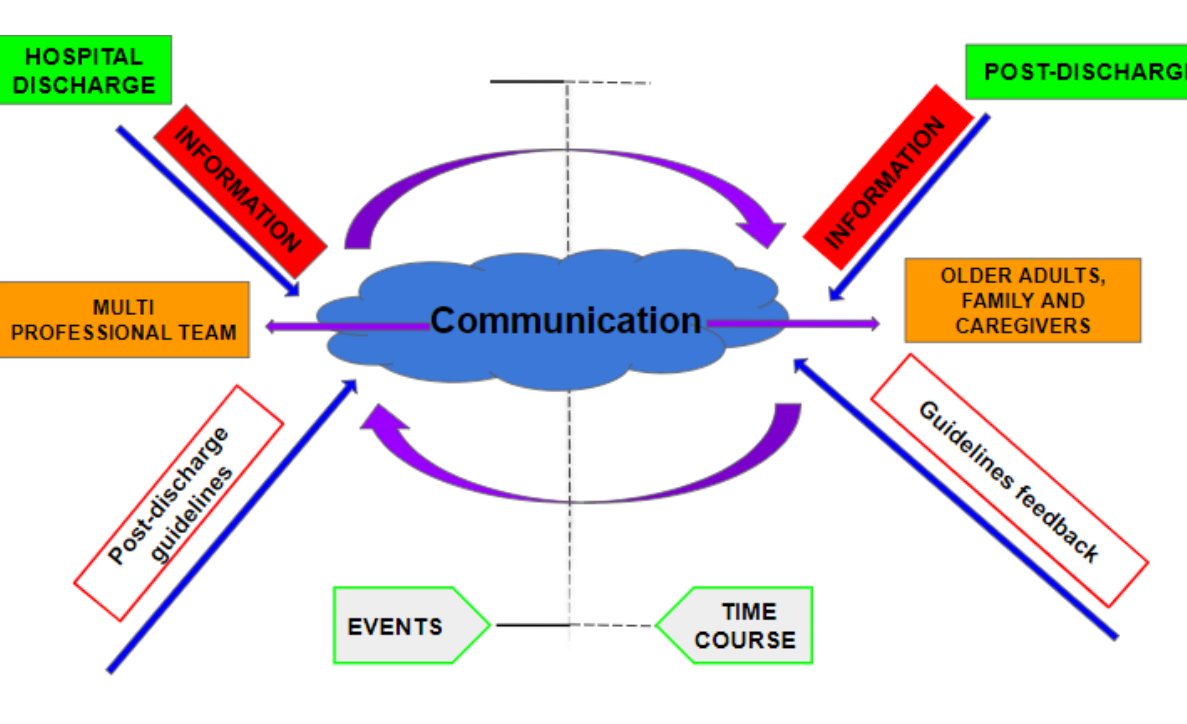
Figure 2. Flow diagram of extramural management, São Paulo,